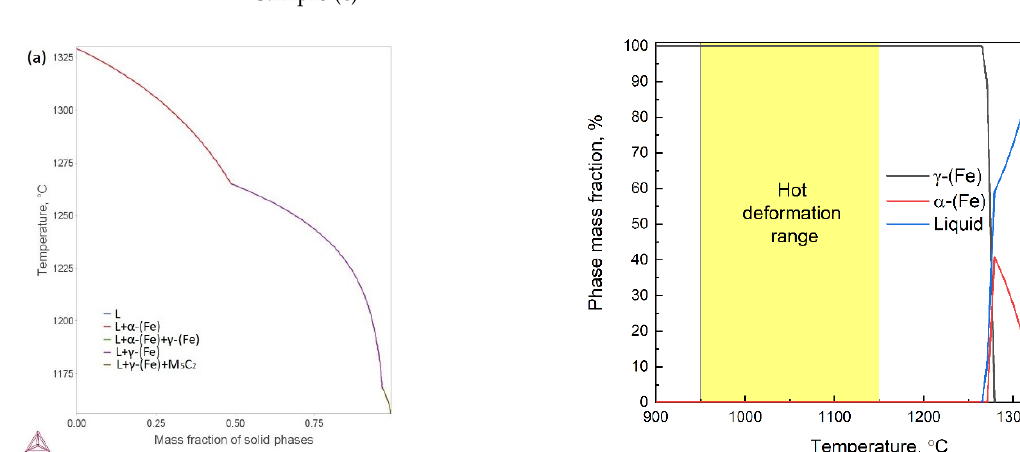
Figure 2. Microstructure of the investigated steel: in the as-cast state ( a ) and before the main deformation stage ( b ). The mapping and the chemical composition of the selected zone in the as-cast sample ( c ).